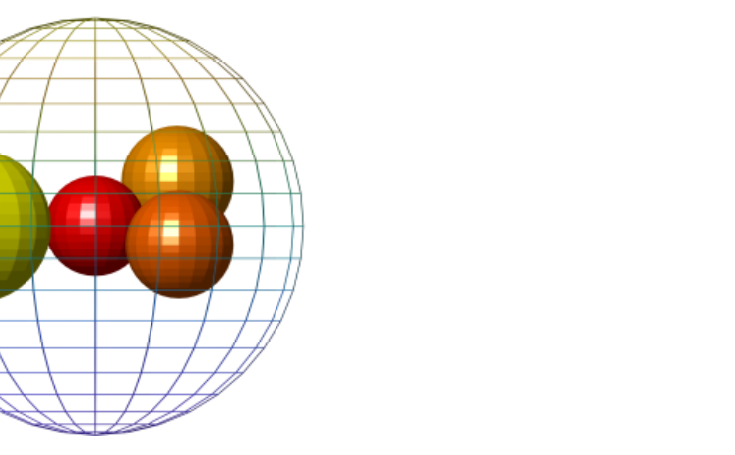
Figure 4. An illustration of the MPTSA algorithm with solid spheres as polydisperse primary particles ( N p = 5; red for the smallest (197 µ m) and yellow for the largest (340 µ m) primary particle) and a hollow sphere of radius T for the addition of a sixth primary particle.